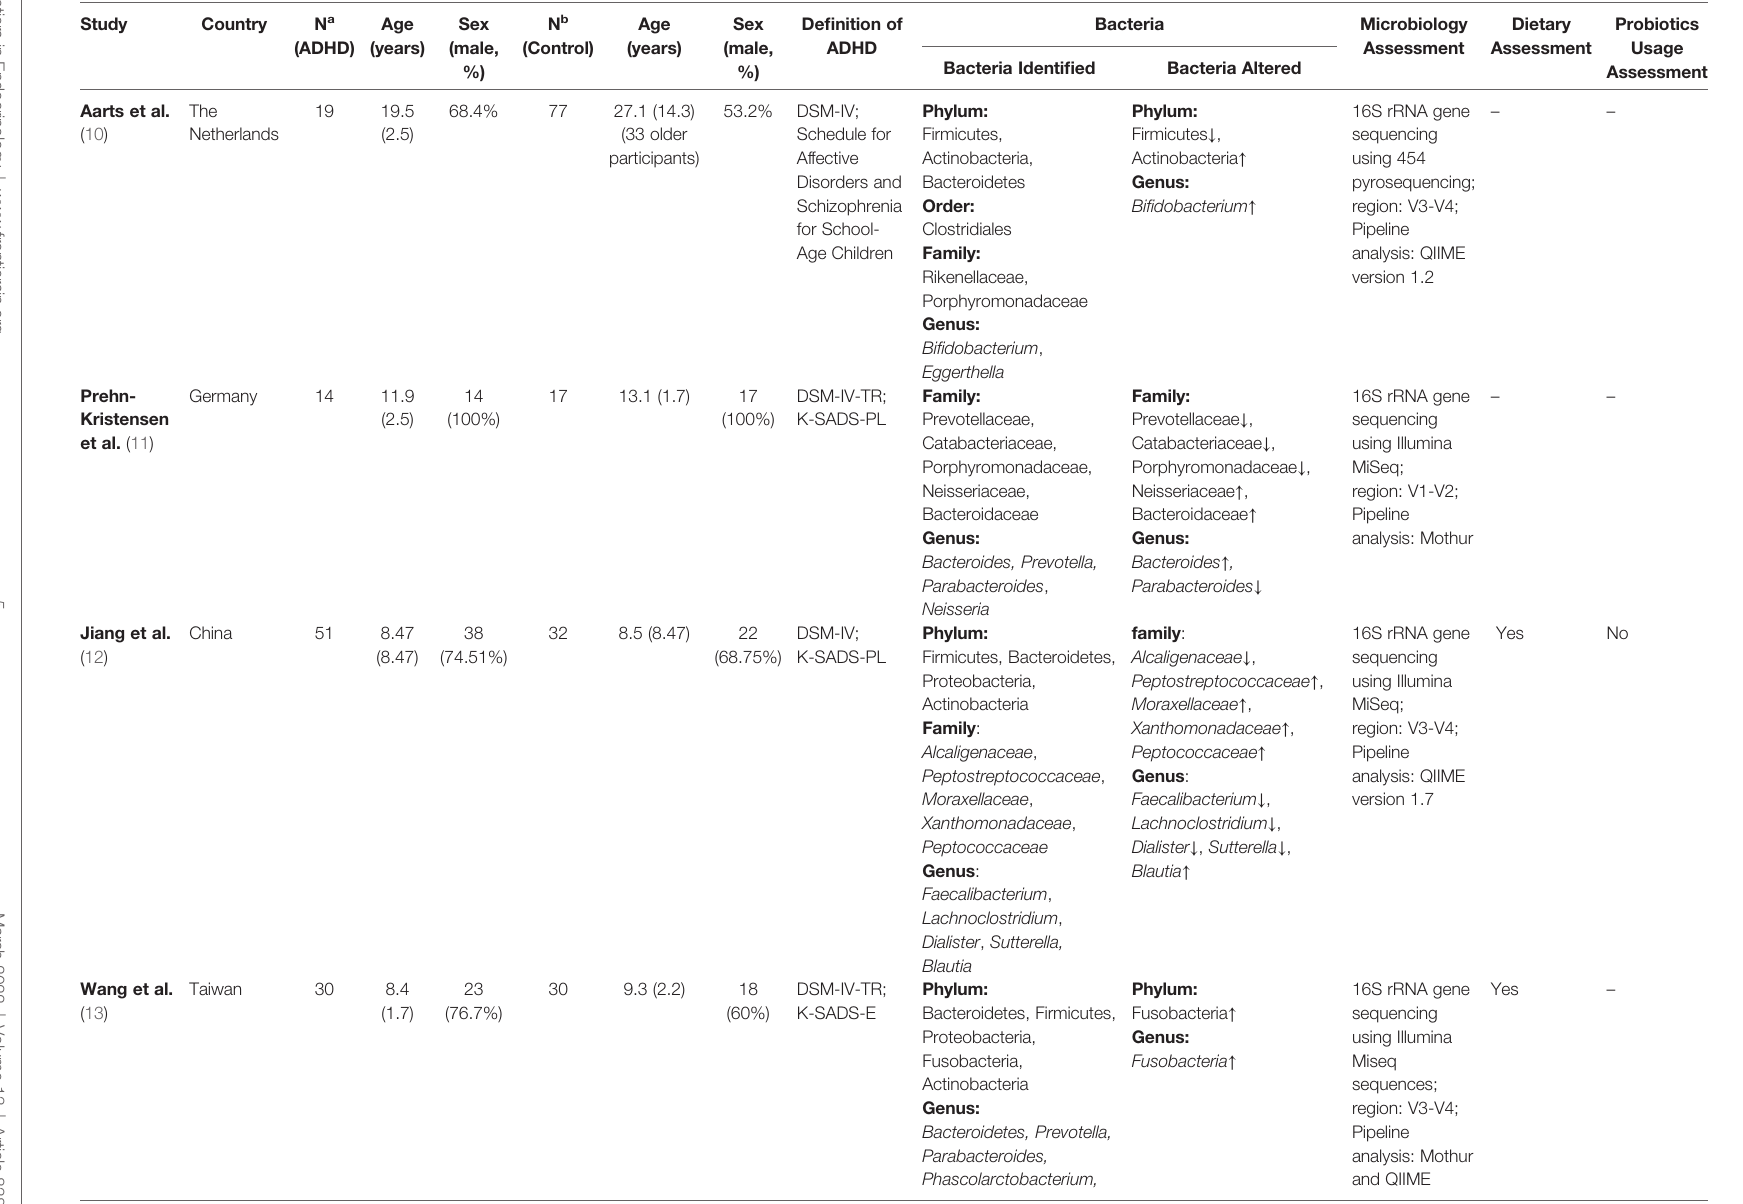
TABLE 1 | Characteristics of the studies included in the